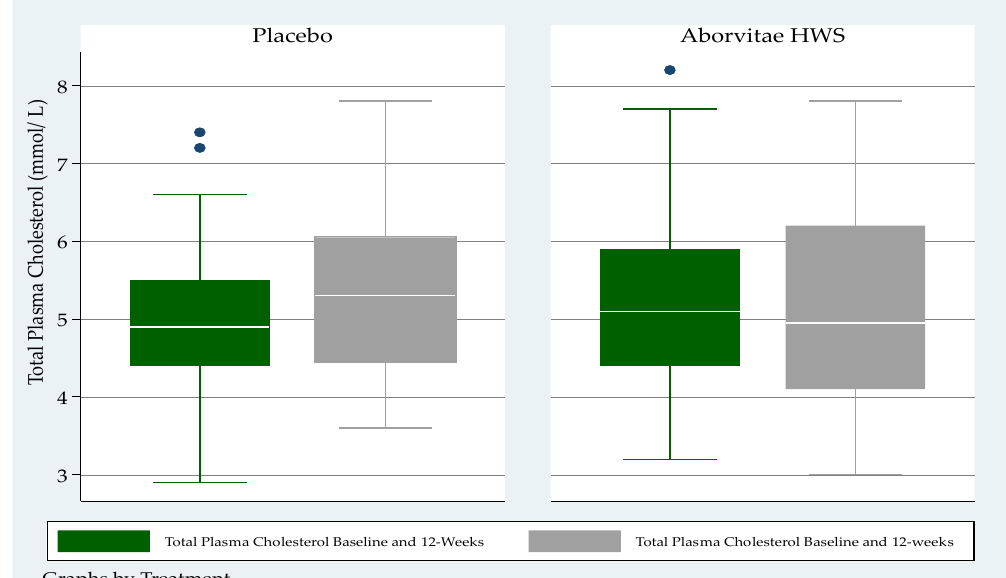
Figure 3. Total plasma cholesterol (mmol/L) at baseline and at the end of the study (week 12) ( p > 0.05). Total plasma triglycerides had a medium (IQR) level for the placebo group, at a baseline of 1.4 mmol/L (1.1–1.8) and 1.5 mmol/L (1.1–1.9) at 12 weeks respectively (Figure 4), whereas total plasma